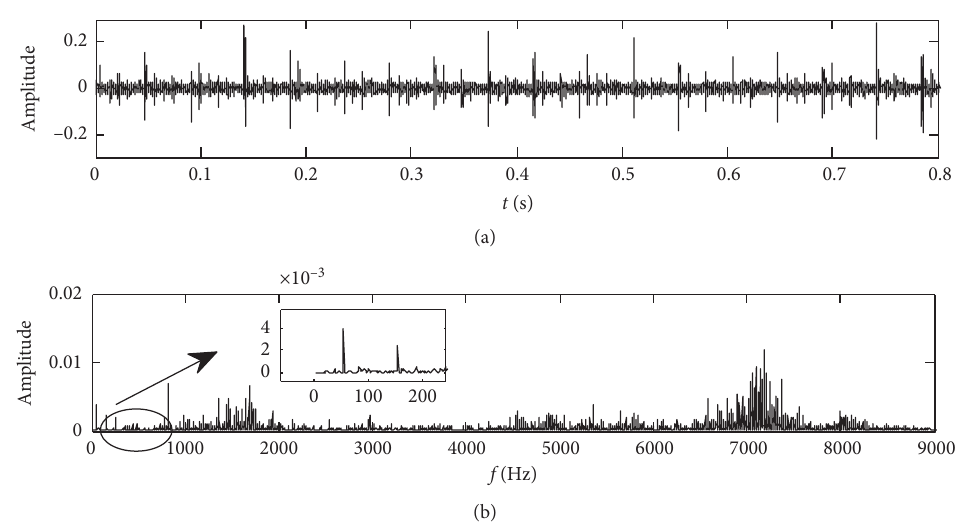
Figure 13: Signal to be